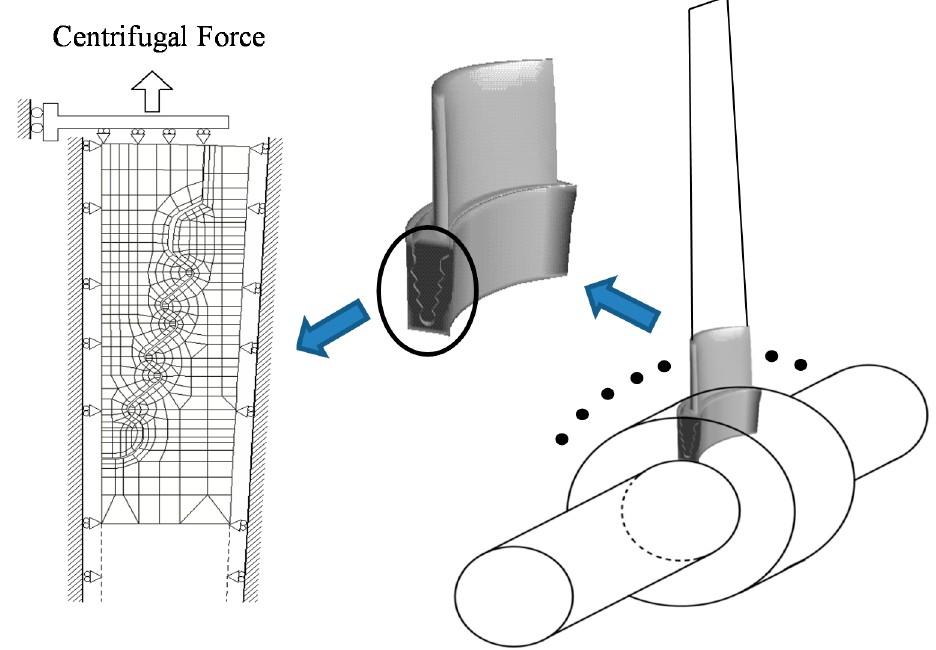
Figure 5. FEM model for fixed part of the blade.